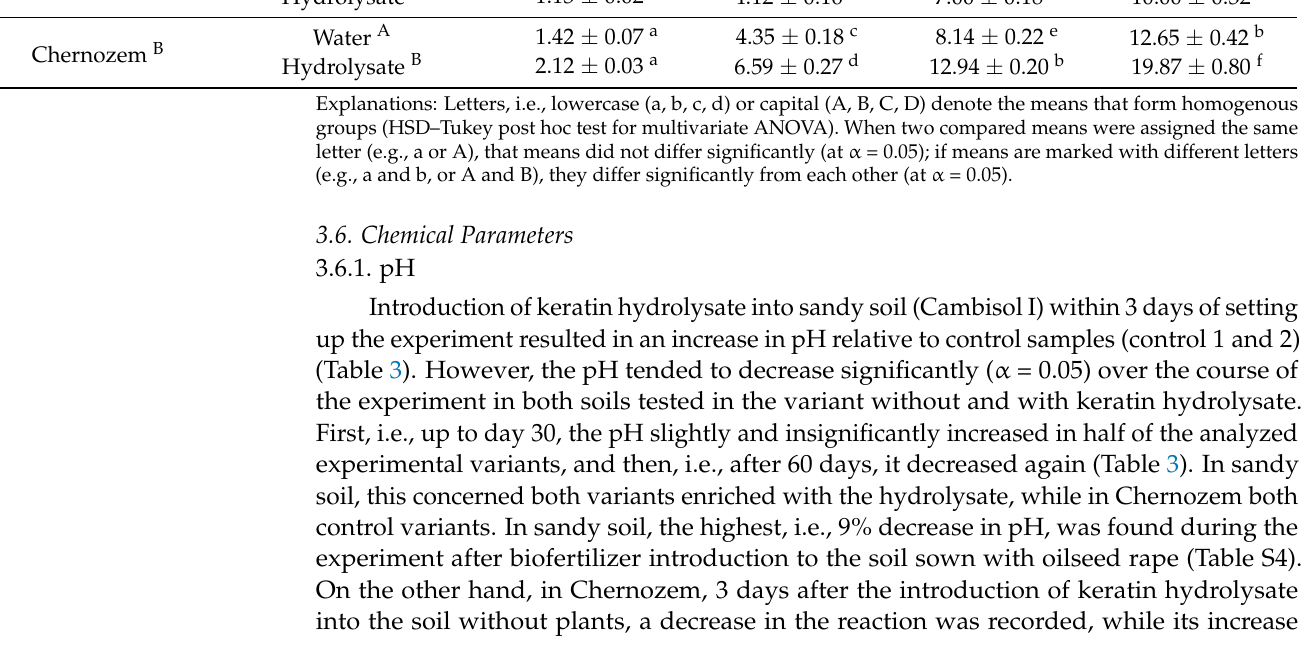
Table 2. Dynamic of changes in Brassica napus L. var. napus biomass.